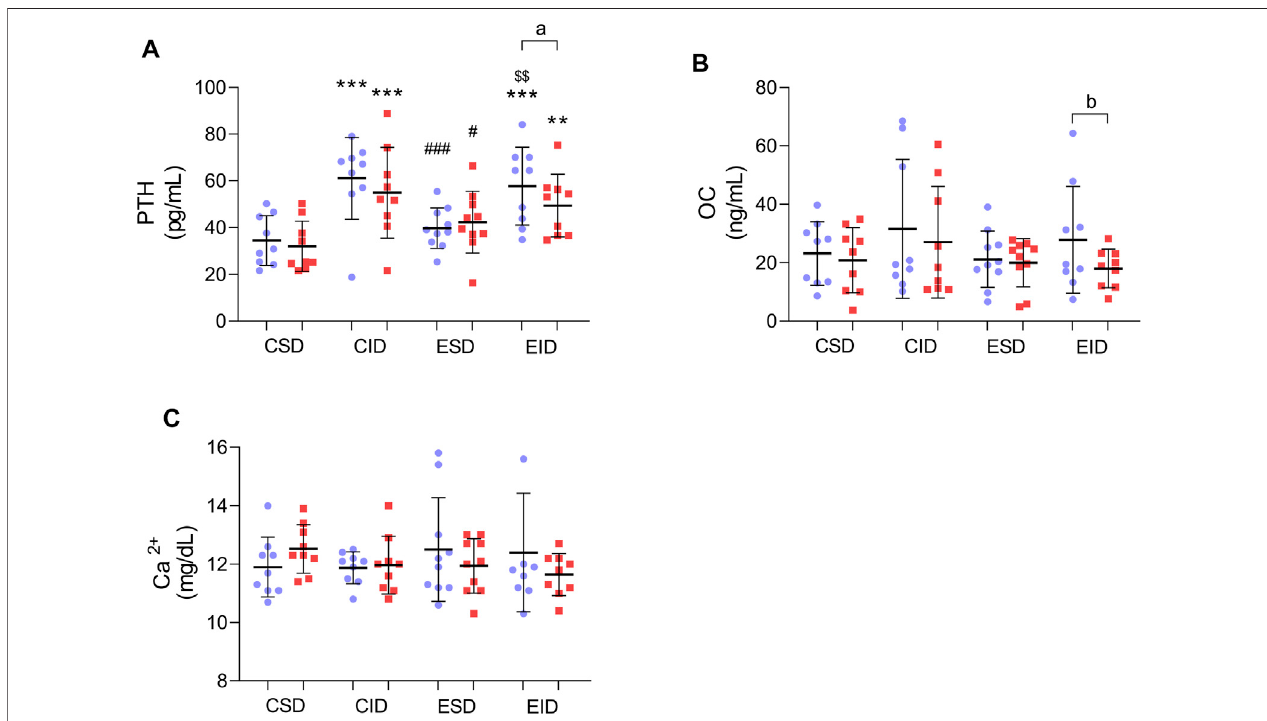
FIGURE 3 | Post-training changes in bone metabolism and PTH. (A) PTH concentration; (B) OC concentration; (C) Ca 2+ concentration. There were signi fi cant differences betweenthe indicated time points: a – p < 0.05, b – p < 0.01; between thegroups: ** p < 0.01, *** p < 0.001vs. CSD; # p < 0.05, ### p < 0.001 vs. CID; $$ p < 0.01 vs. ESD. The data are presented as the means ± SEM; plain — before the intervention; strips — after the intervention.